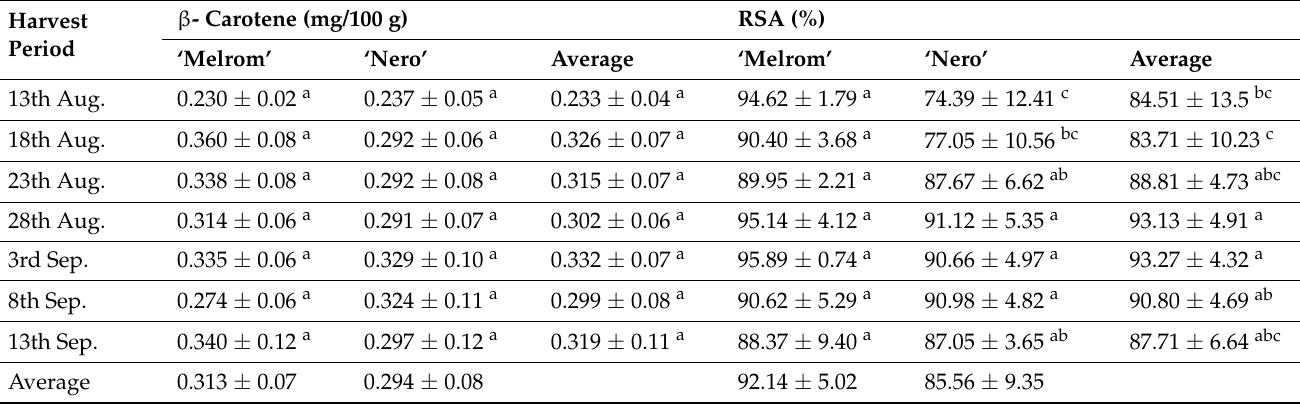
Table 4. Variations in β -carotene content and the radical scavenging activity (anti-DPPH) of dehy- drated chokeberry pomace during the harvest season